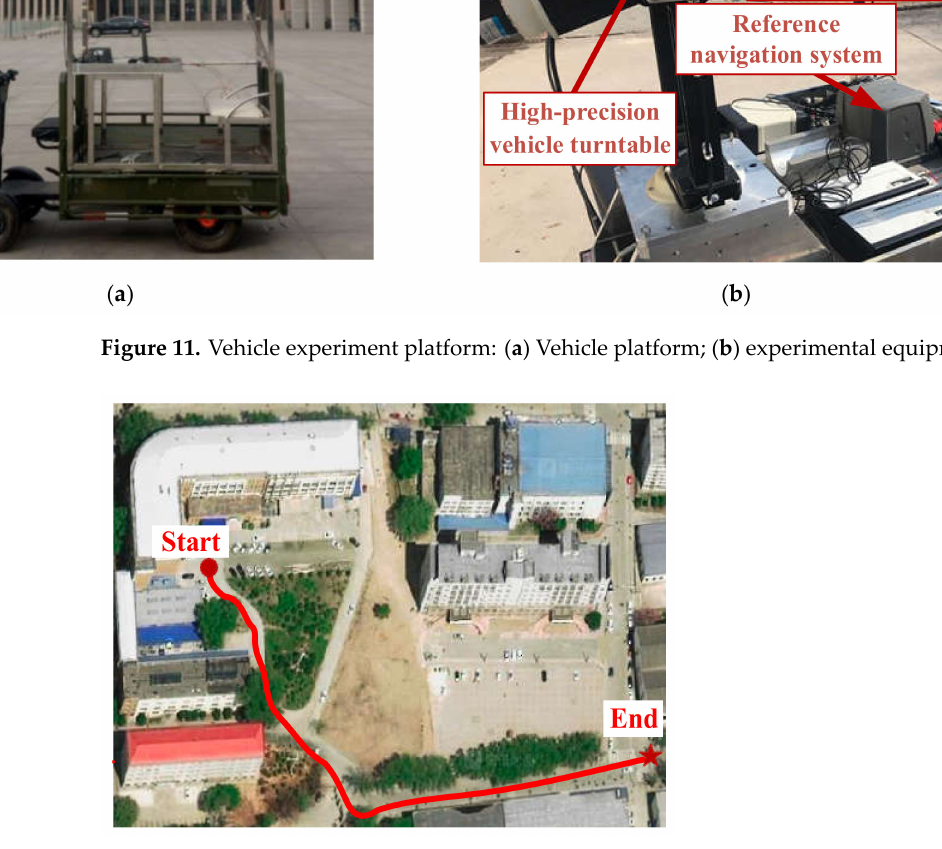
Figure 12. Vehicle experiment